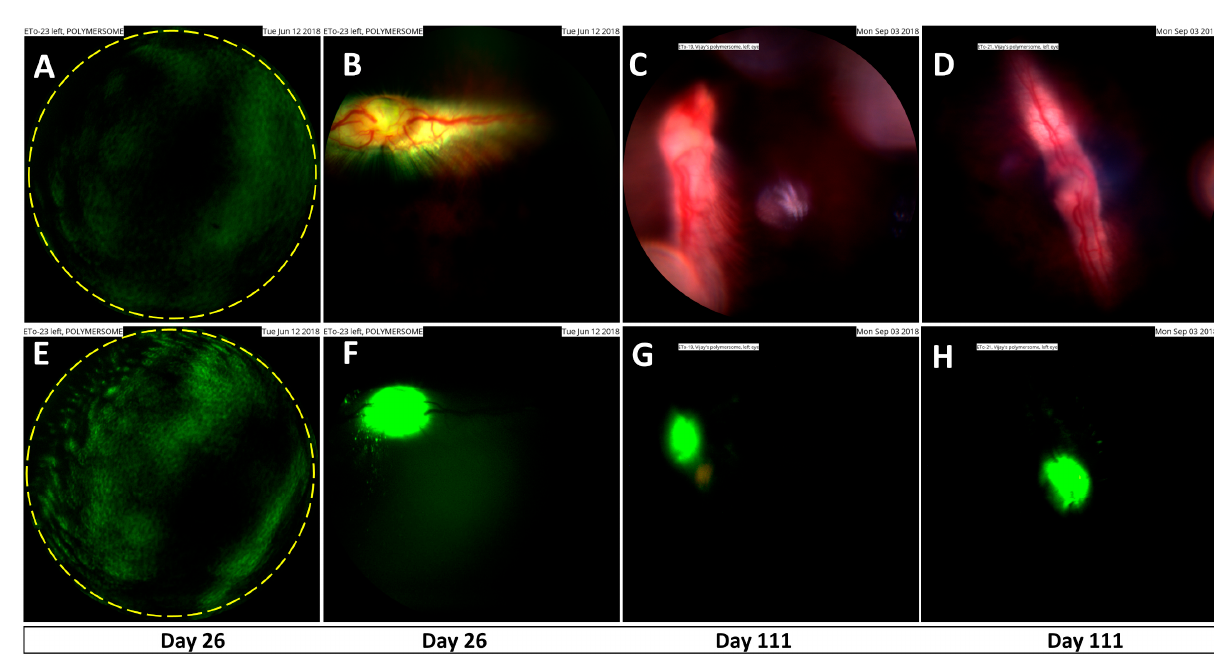
Figure 4. Fundus imaging in rabbit eyes after intravitreal injection of BODIPY labeled neutral polymersomes (PPP). Upper panel shows full color imaging and lower panel represents fluorescence imaging. ( A , B ) Polymersome distribution in the rabbit vitreous after 26 days; ( C – F ) accumulation of polymersomes at the optic nerve head region; ( G , H ) accumulation of polymersomes at the optic nerve head region (horizontal axis). Without injection fluorescence images would be completely black.